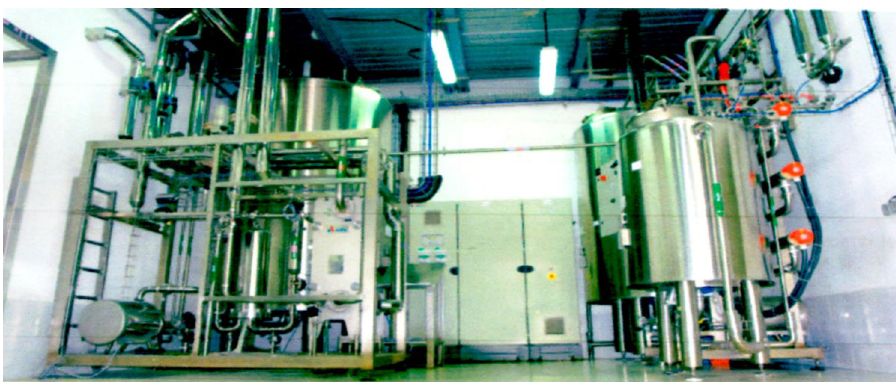
Fig. 2 The water purification